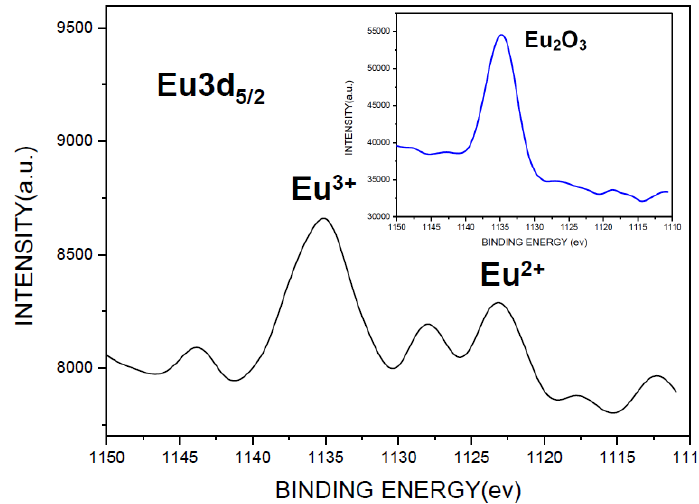
Figure 9. XPS spectra in the Eu 3d 5/2 region of reactant Eu 2 O 3 (inset) and the synthesized